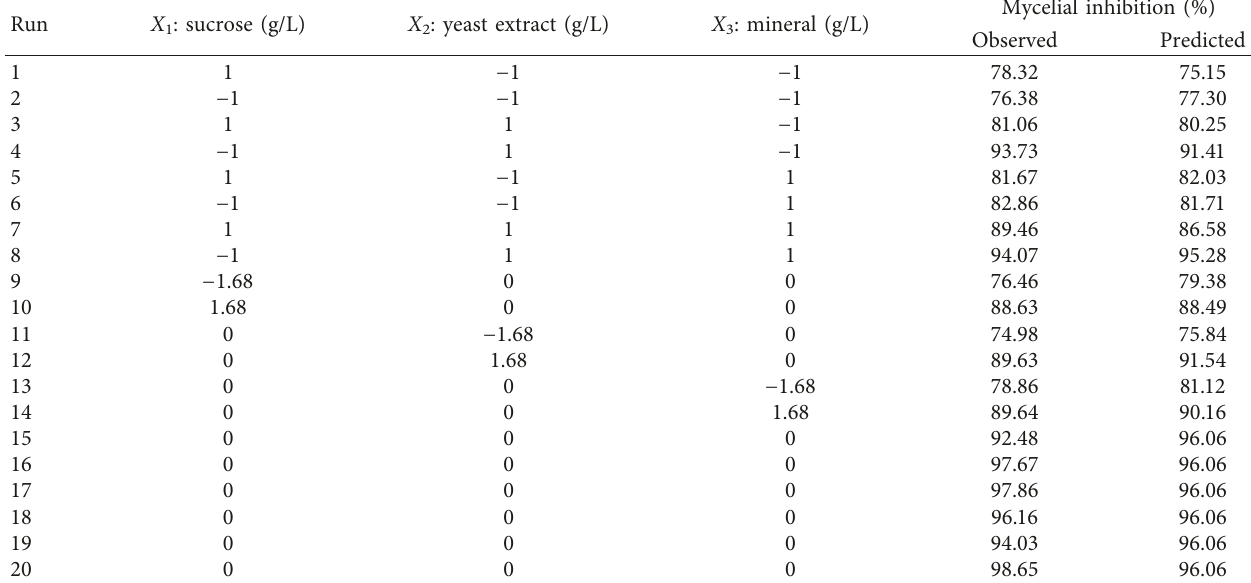
Table 6: Central composite design of the three variables and their corresponding experimental data.